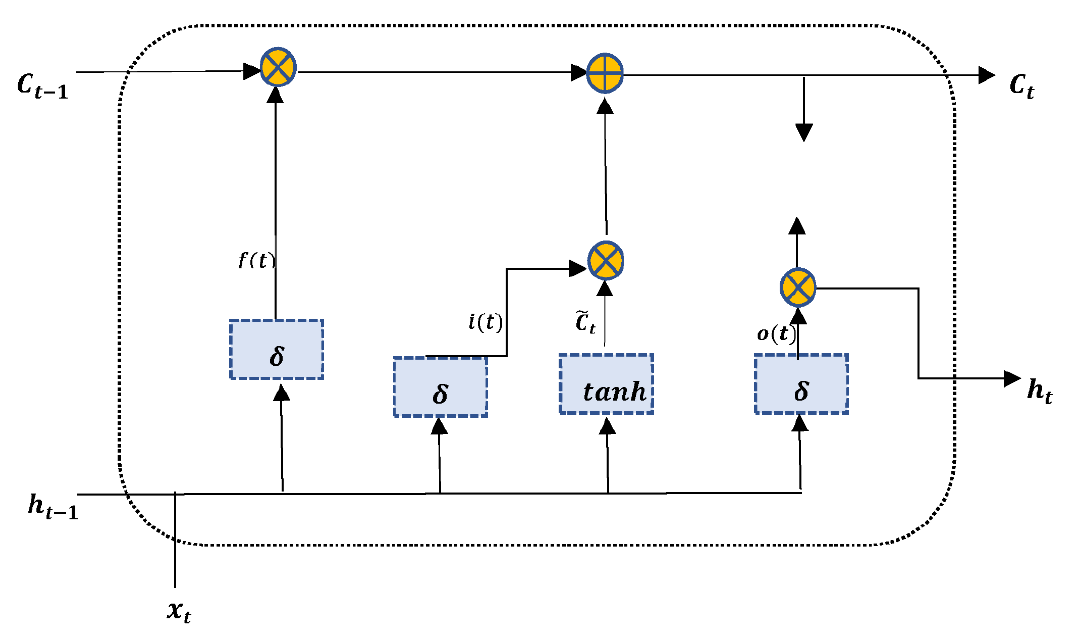
Figure 2. The typical structure of an LSTM cell.